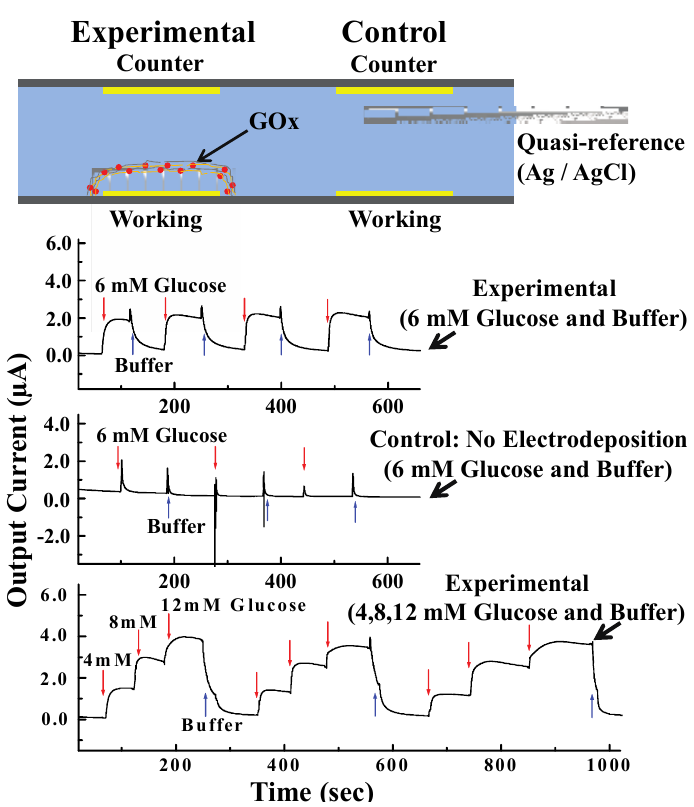
Figure 3. Experimental set up and output upon exposure to glucose solution. Reprinted with permission from [26]. © 2011 Wiley-VCH Verlag GmbH&Co.